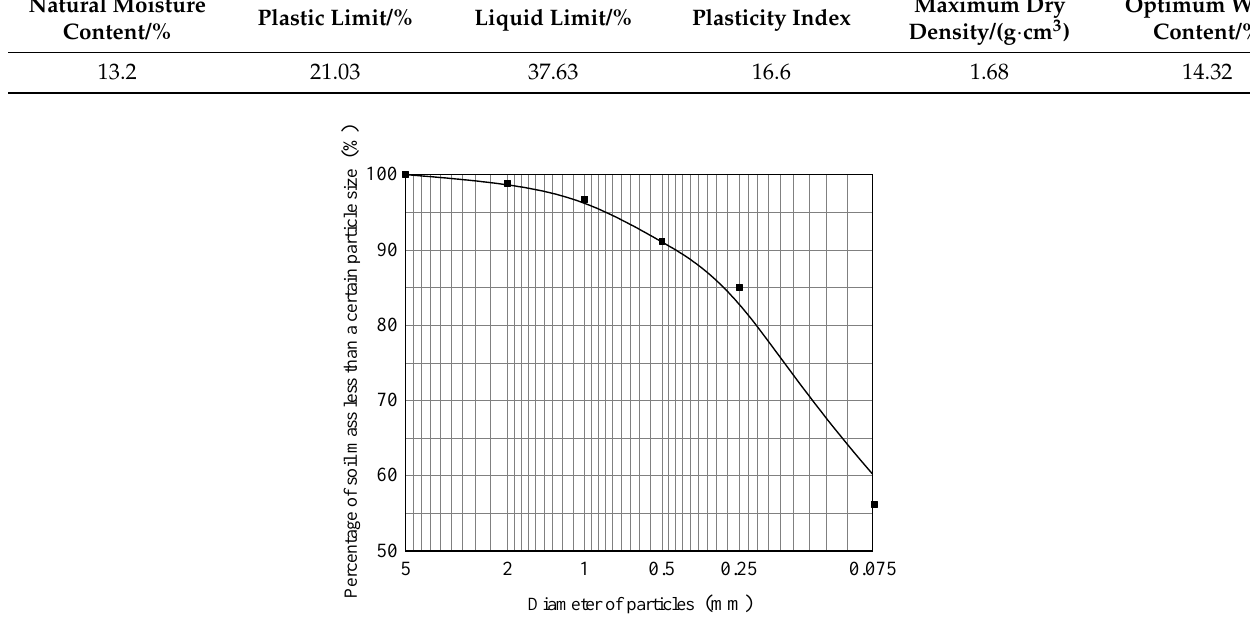
Figure 2. Particle-size distribution curve.